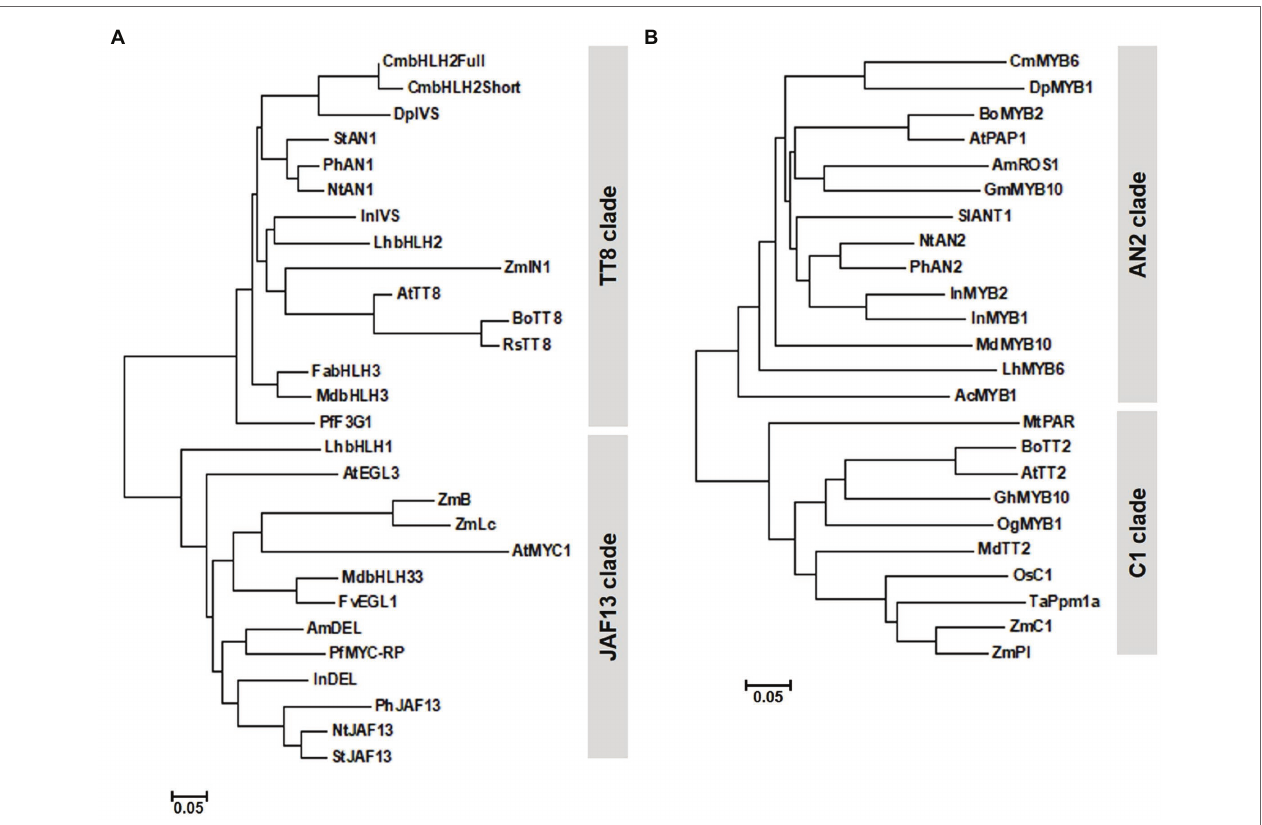
FIGURE 2 | Phylogenetic relationships of anthocyanin biosynthetic regulators in chrysanthemum and other species. (A) Phylogenetic tree of CmbHLH2 proteins from WO and TRO and subgroup IIIf bHLH proteins from other plants. (B) Phylogenetic tree of CmMYB6 and R2R3 MYB proteins from other plants. The phylogenetic tree was constructed using the neighbor-joining method with MEGA6